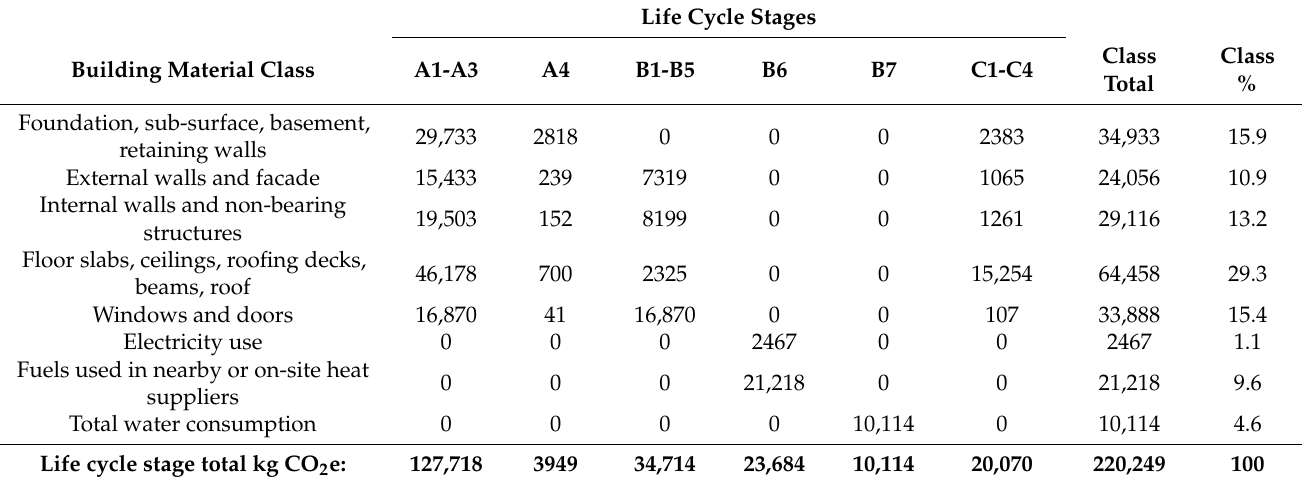
Table 1. The An Corr á n building’s GWP (kg CO 2 e) environmental impact attributed to the main building material classes over each life cycle stage.